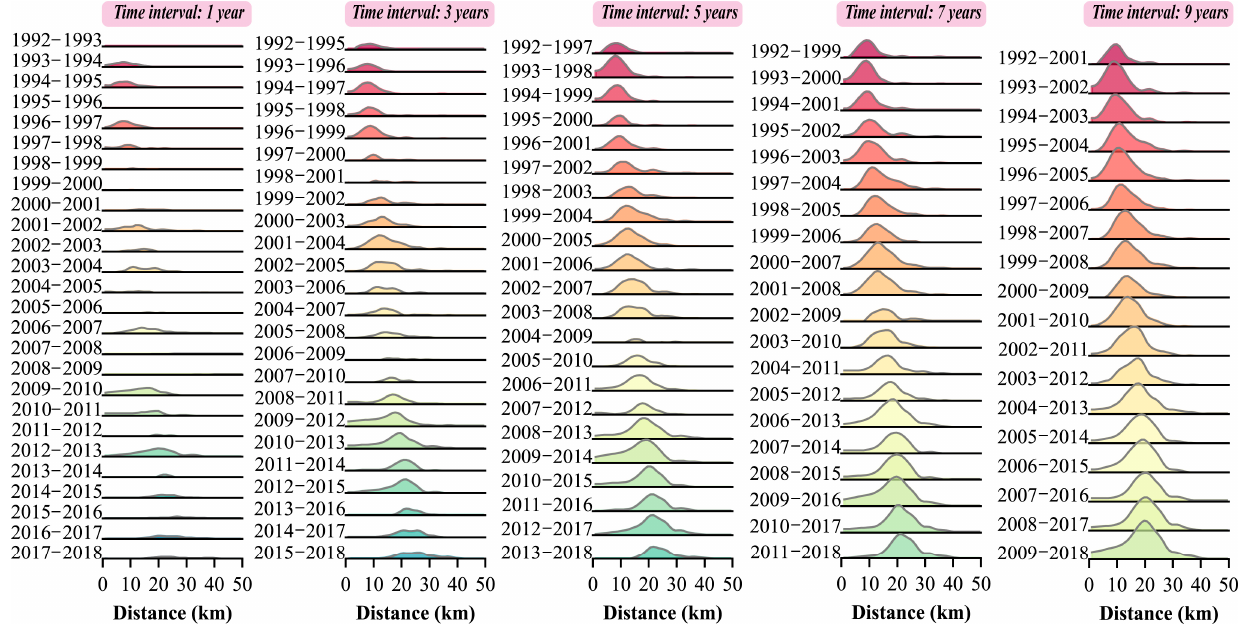
Figure 7. Wave of spatiotemporal variations in intensity of human activities in a typical city, Wuhan, from 1992 to 2018, when DN min = 30 and the time interval varies from 1 to 9 years with increments of 2 years.